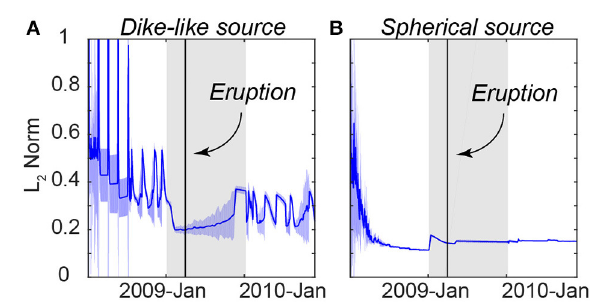
FIGURE 5 | Normalized L 2 norm comparing the misfit between the EnKF data assimilation results and the InSAR data. (A) L 2 norm for the first step EnKF, which uses a dike-like source to track the subsiding signal. (B) L 2 norm for the second step of the EnKF, which uses McTigue’s model (McTigue, 1987) of an inflating spherical source to track the uplifting signal. The blue solid lines and the blue shaded regions are the mean and standard deviations respectively of the L 2 norms of the 200 models in the